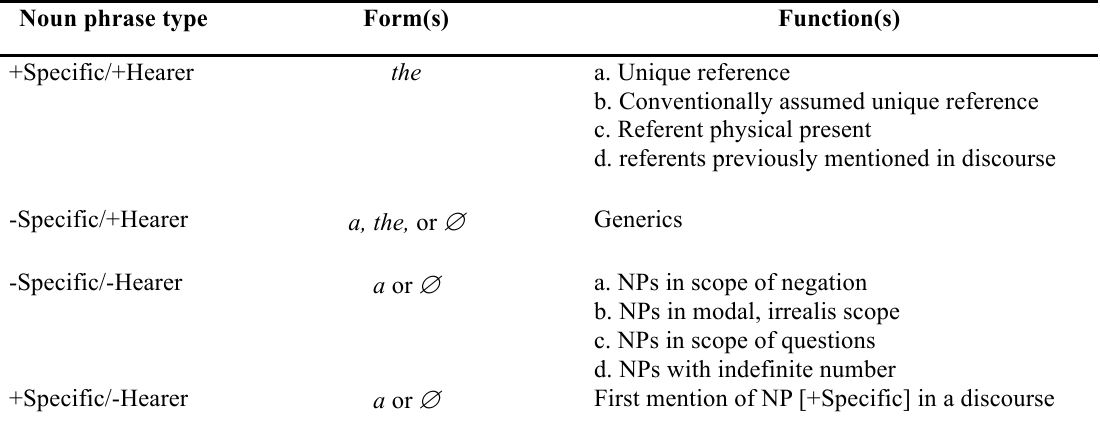
Bickerton’s (1975) ‘semantic wheel’ extracted from Huebner